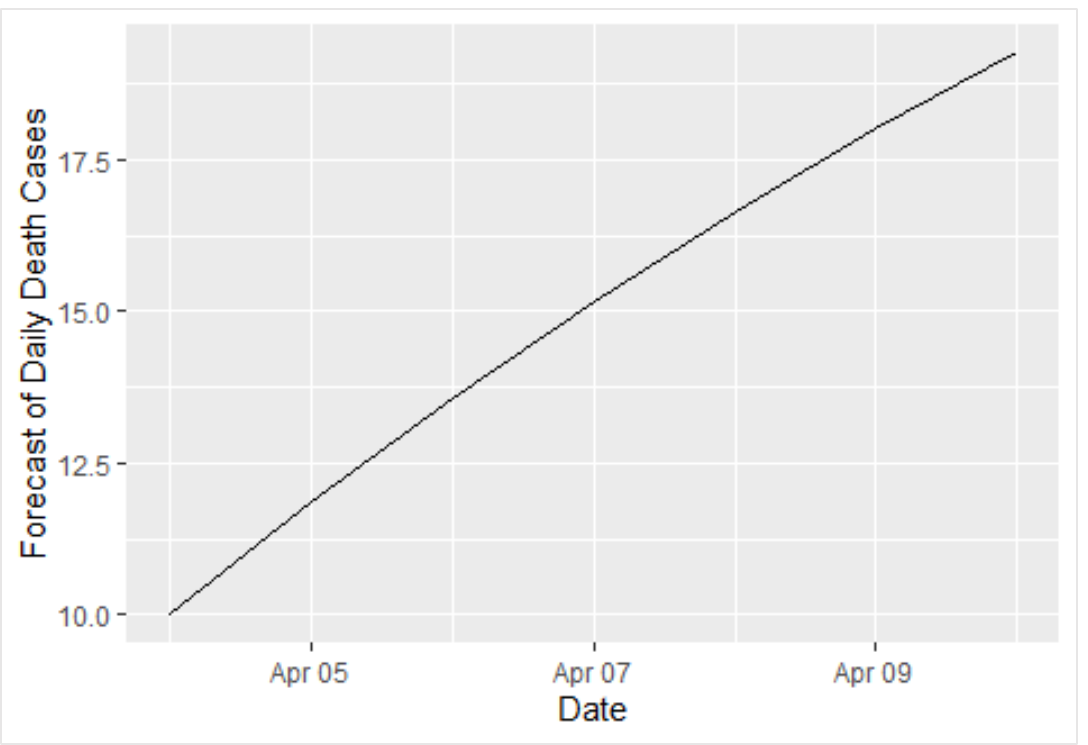
Figure 10. Forecast plot of death cases caused by COVID-19 in Jakarta.